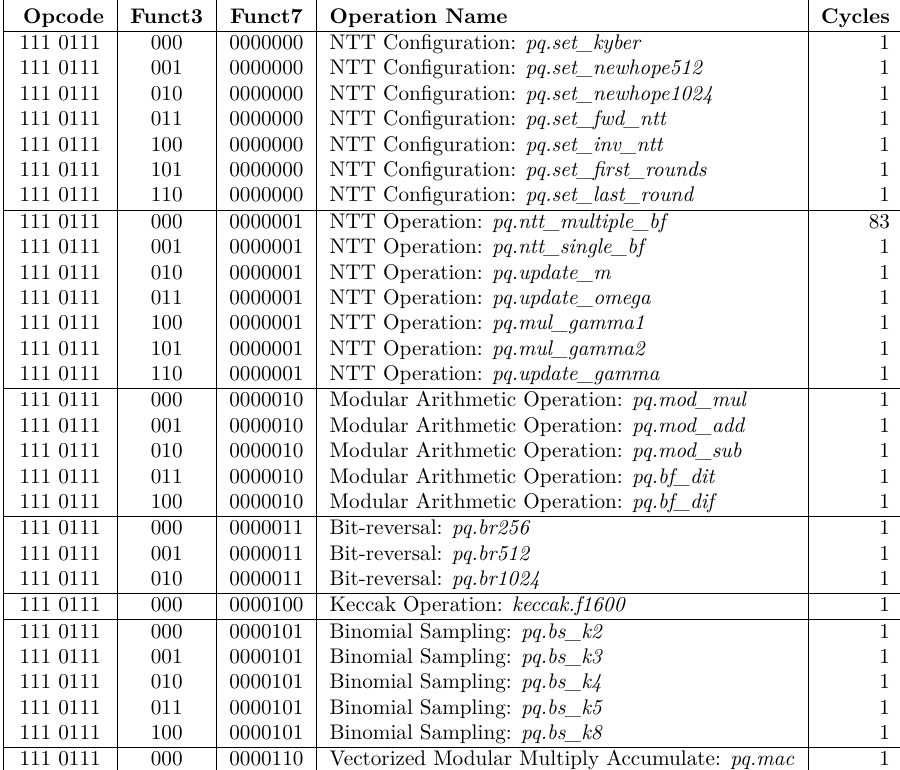
Table 10: PQ ISA